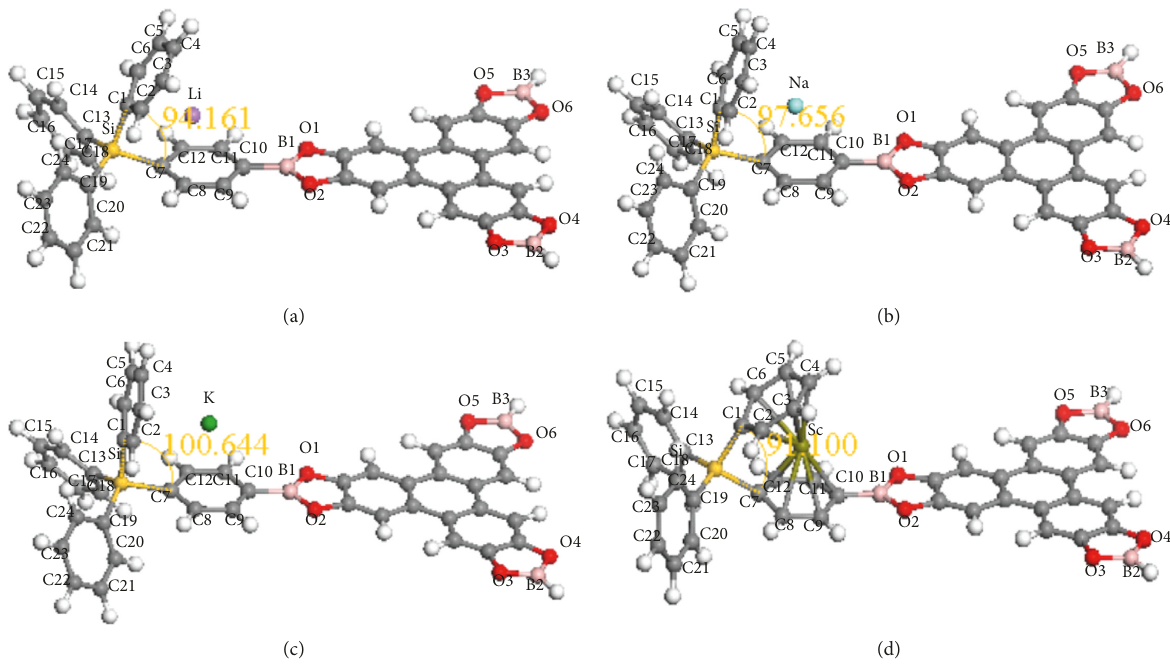
Figure 2: Optimized geometries of all the metal-doped COF-105 complexes. Dark yellow: Si; dark grey: C; grey: H; pink: B; red: O; purple: Li; blue: Na; green: K; breen: Sc. Partial atom numbers of C, B, and O atoms were presented. (a) Li@COF-105. (b) Na@COF-105. (c) K@ COF-105. (d) Sc@COF-105. Table 2: Partial geometrical data of the metal-doped complexes (metal@COF-105). Angle ( ° )/atom distances